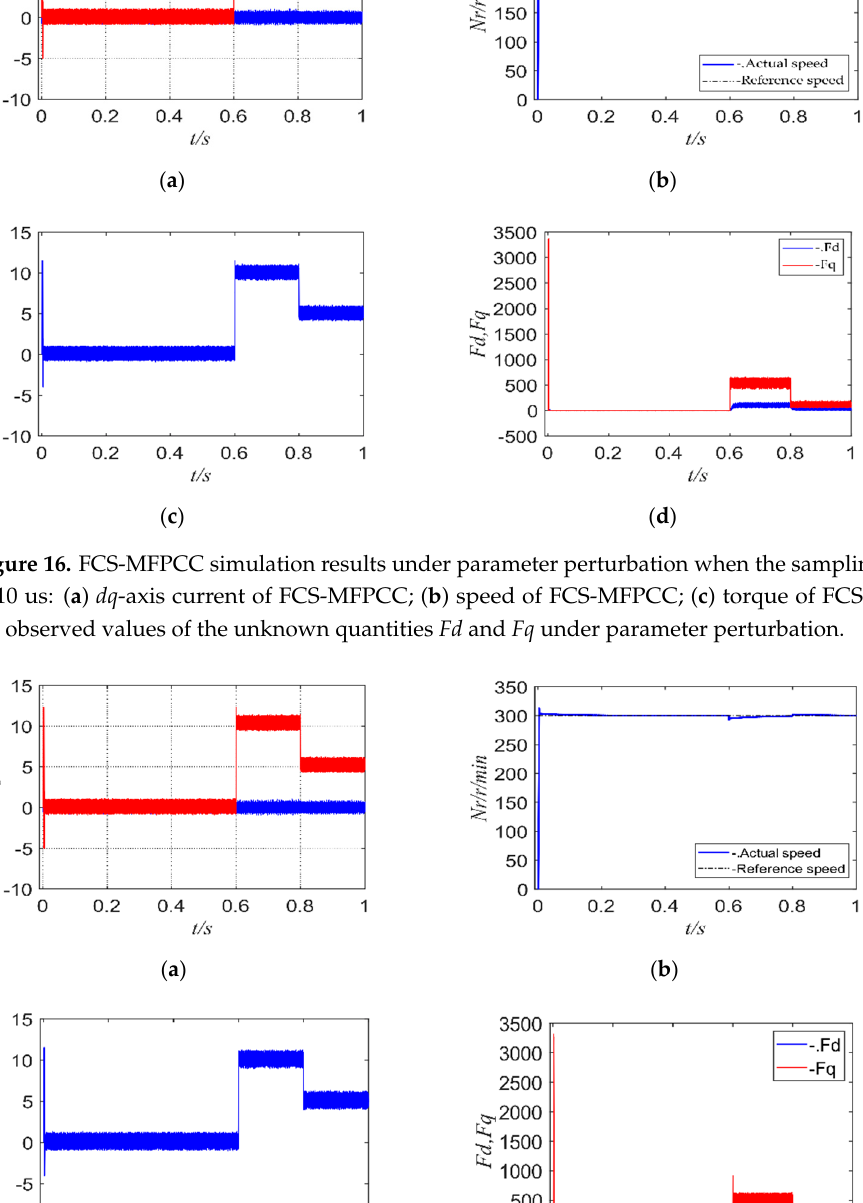
Figure 15. FCS-MPCC simulation results under parameter perturbation: ( a ) dq- axis current of FCS-